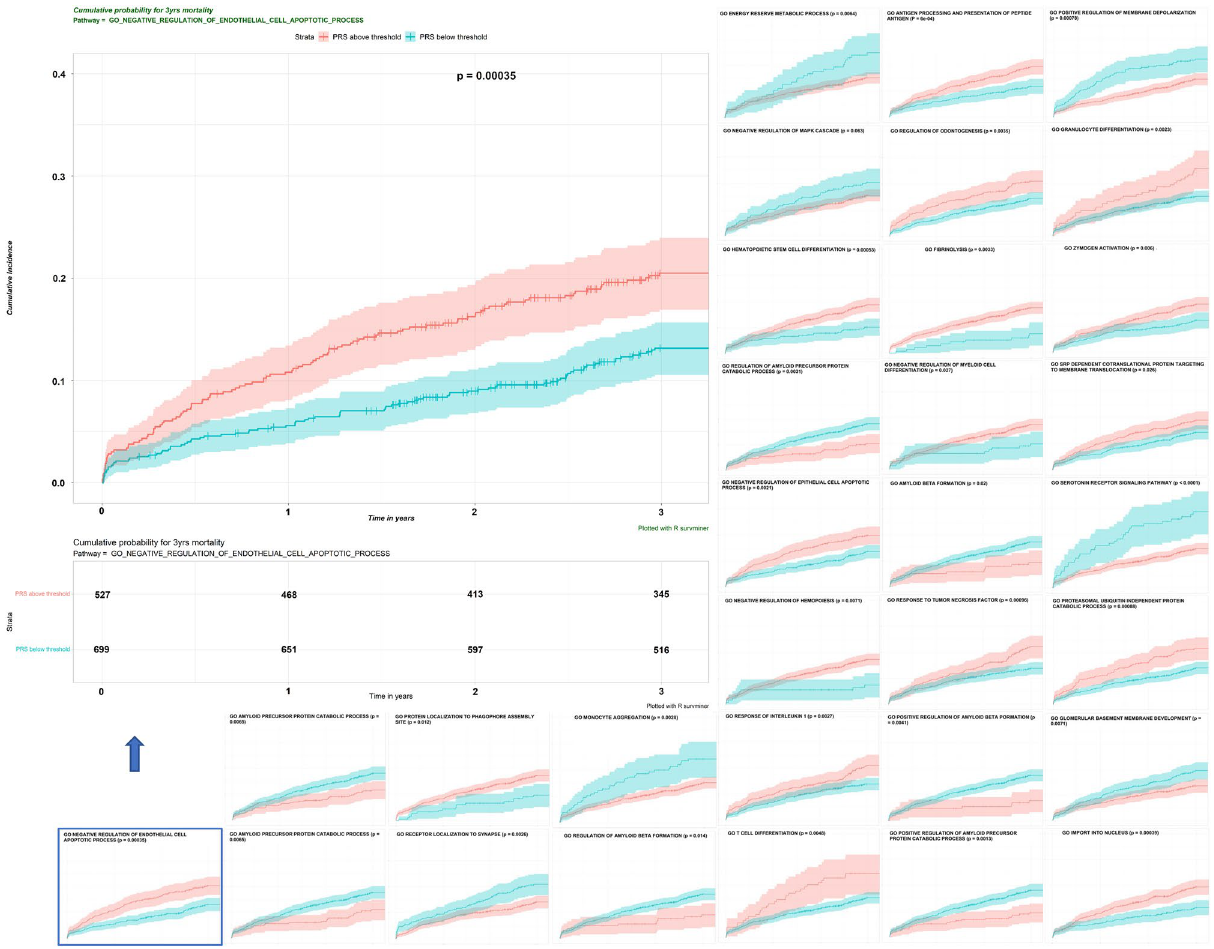
Figure 3. Kaplan–Meier plot of the two groups created by the cutpoint for PRS. All the pathway-specific PRSs for 3-year mortality identified by univariate CoxPH were dichotomized by the corresponding cutpoint, and Kaplan–Meier analysis for each binary PRS was conducted. We simulated the null distribution using the conditional Monte Carlo method and compared it with the exact distribution for the log-rank statistic to get the lower bound of the p-value for each pathway-specific PRS. P value derived from the Log-rank test was